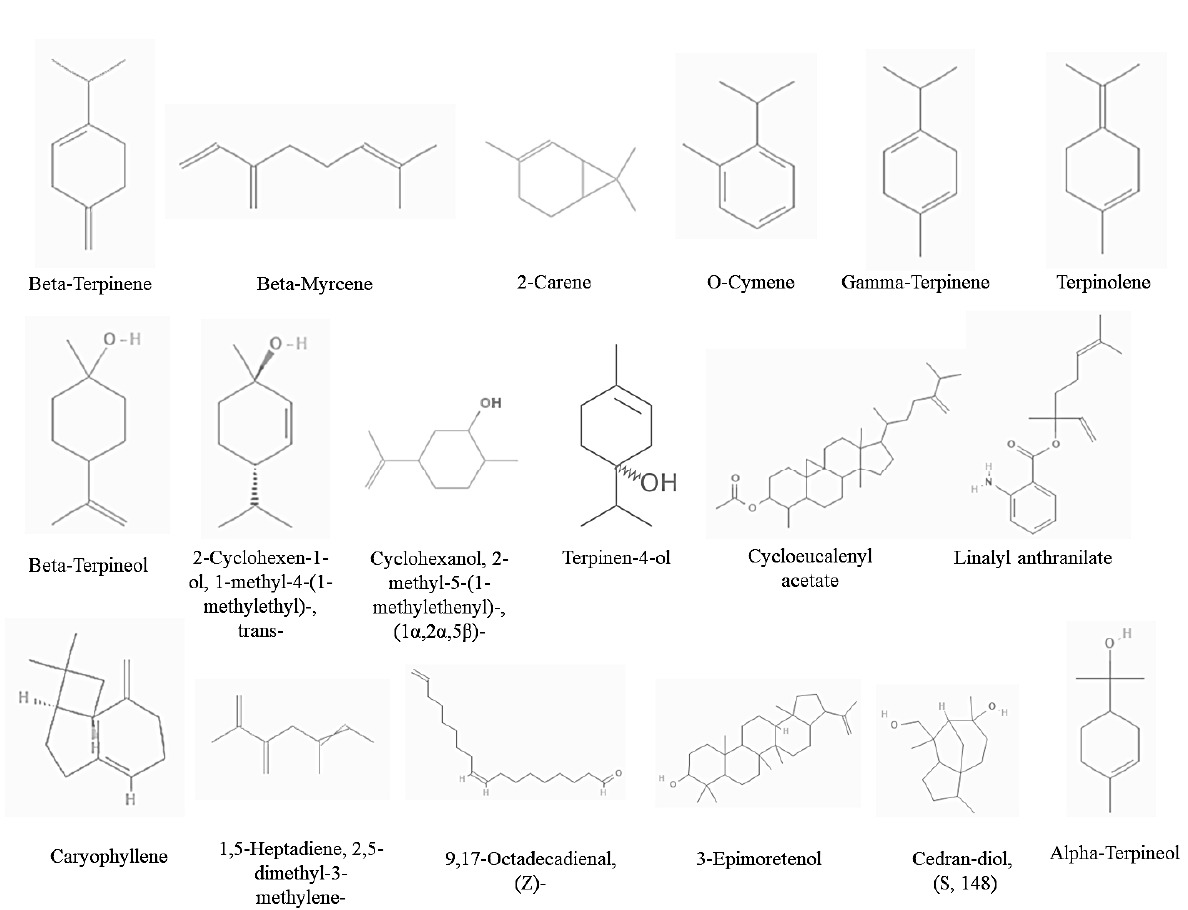
Figure 2. The chemical structures of compounds identified in Origanum vulgare essential oil.